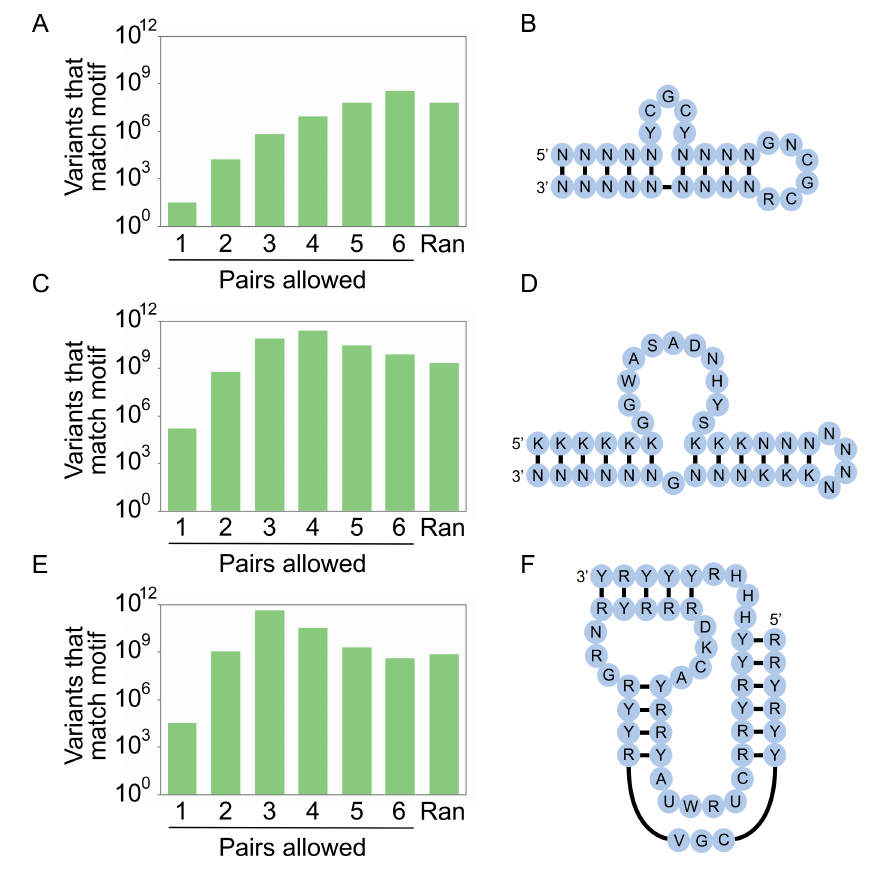
Figure 7. Secondary structure libraries based on known motifs for library sizes of 10 15 sequences. ( A ) Expected number of unique variants with the potential to form the secondary structure of a DNA aptamer that binds streptavidin [22] in a library of 10 15 sequences using different coding strategies to encode base pairs. The column labeled “Ran” indicates the number for a library generated at the optimal rate of random mutagenesis using the method described in Section 4.3. ( B ) Possible secondary structure library for this motif. ( C , D ), the same, but for an RNA aptamer that binds ATP [23–25]. ( E , F ). the same, but for a kinase ribozyme that thiophosphorylates itself using GTP γ S as a substrate [19,20]. Y = C or T (U); R = A or G; K = G or T (U); W = A or T (U); S = C or G; D = A,